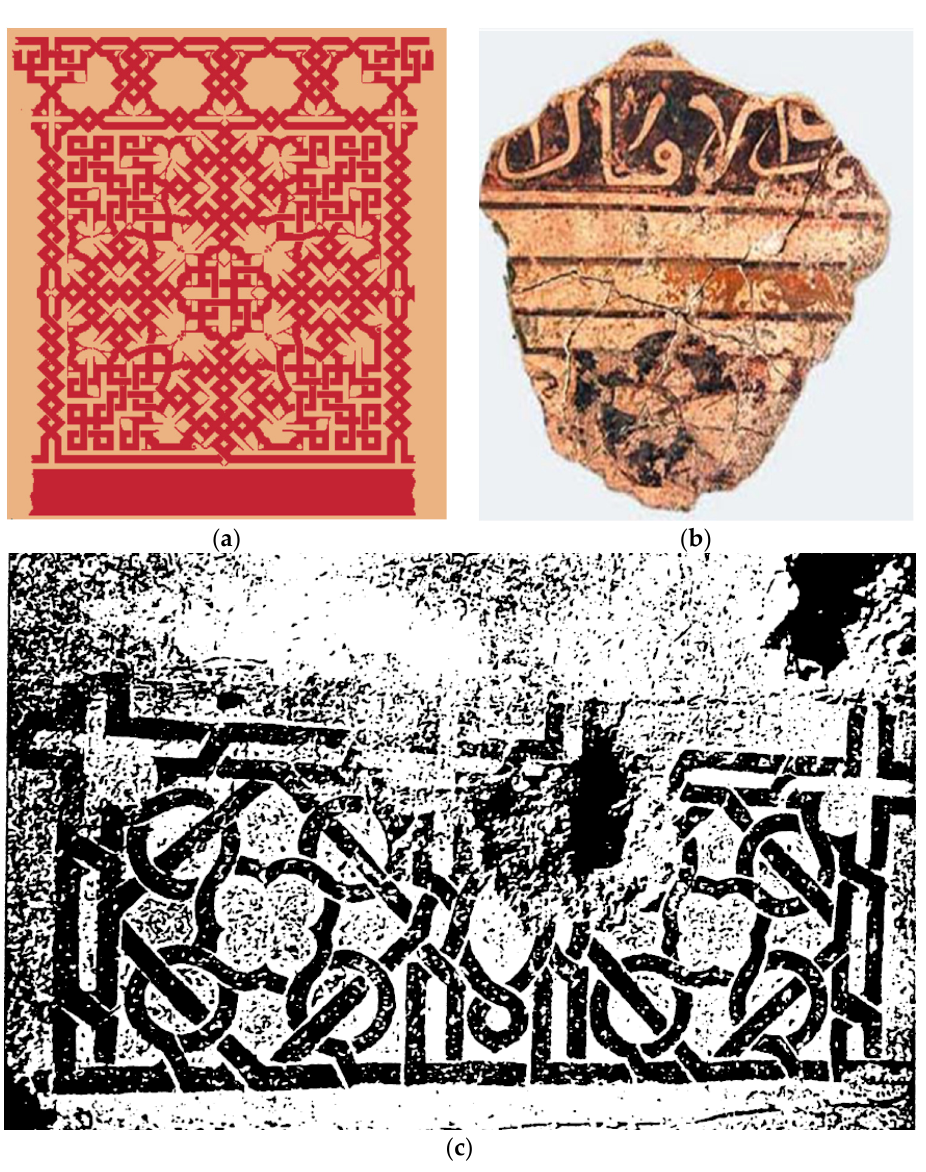
Figure 8. Geometric paintings in the 12th century: ( a ) Palacio del Yeso, Sevilla (Valle and Respaldiza 2000, p. 59); ( b ) Arrayán Street, Seville (Seville Archaeological Museum) (Villén 2012, p. 137); ( c ) La Chanca quarter, Almería (R. 1945, p. 172).